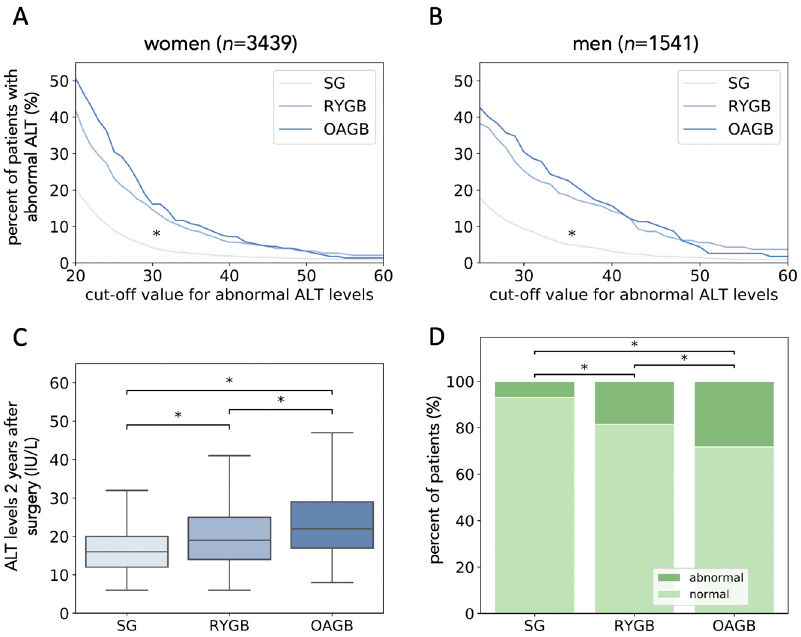
Figure 1. SG reduces the probability of abnormal ALT levels in the study population and retrospec- tively matched cohort. A-B: The percentage of female ( A ) and male ( B ) patients with abnormal ALT levels as a function of the cutoff defining abnormal ALT levels, per surgery. * p < 0.001 using Kruskal Wallis H test followed by Mann-Whitney U-test for pairwise comparison of SG with RYGB and SG with OAGB. ( C ): ALT levels two years after surgery in matched populations. n = 319 per surgery. * p < 0.01. ( D ): The percentage of patients with high ALT levels per surgery in matched populations. * p < 0.01 using the χ 2 test. SG: Sleeve Gastrectomy; RYGB: Roux en Y Gastric Bypass; OAGB: One Anastomosis Gastric Bypass; ALT: Alanine Aminotransferase. Table 2. Pre-surgical parameters of patients with normal and abnormal ALT levels two years post-surgery. Normal ALT Levels Abnormal ALT Post-Surgery ( n = 4435)